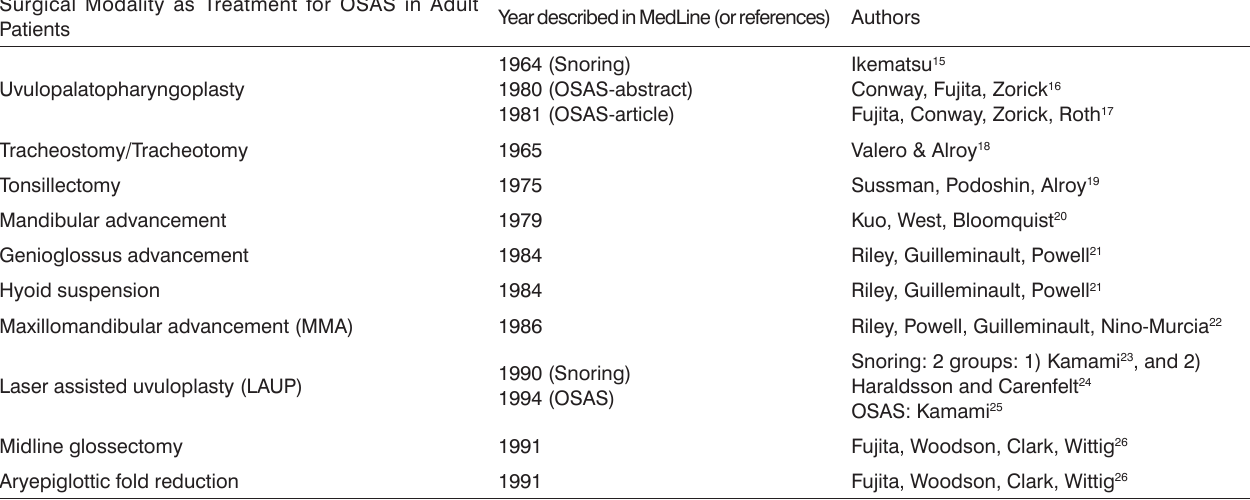
Table 1. The evolution of sleep apnea surgeries. Listed chronologically based on a MedLine search and references from those